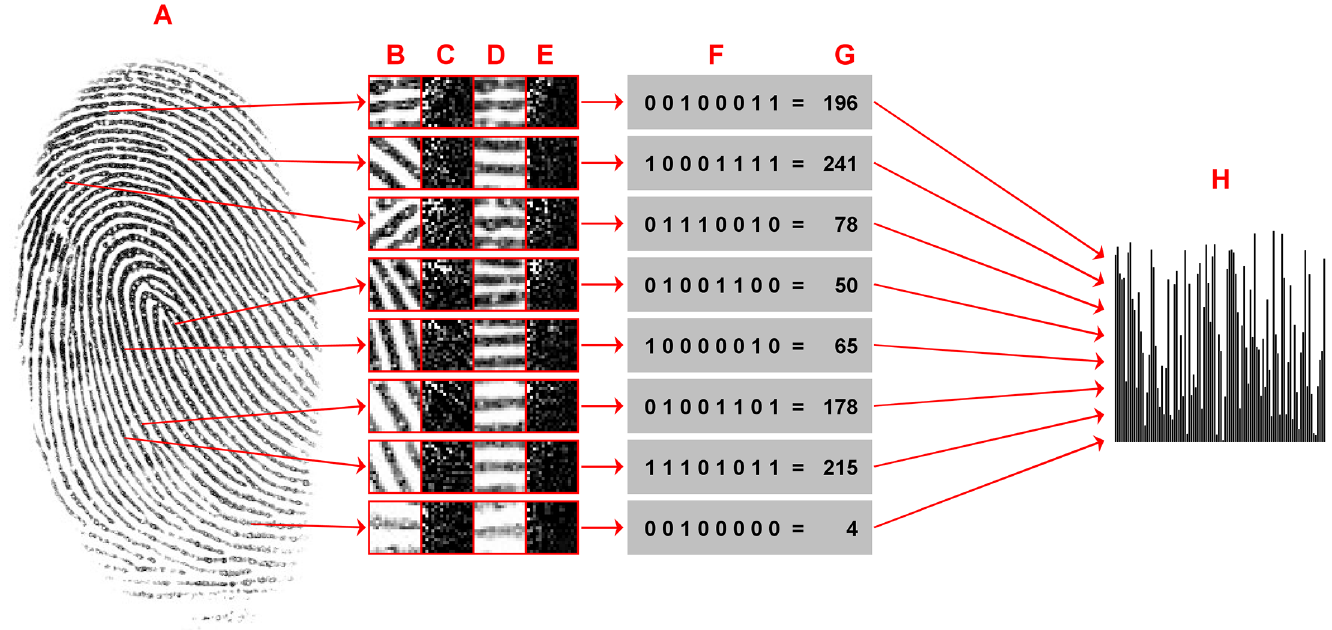
Fig 1. Overview over the proposed feature vector computation. Every foreground pixel of a fingerprint (A) is considered as the center of a small image patch. Instead of using the original patches (B) and their DCT coefficients (C), we take the local orientation into account to obtain rotation invariant patches (D) and their DCT coefficients (E). We compute the binary pattern (F) by comparing selected pairs of two DCT coefficients from (E), see Eq (2). The pattern (F) is converted intoa bin number (G), see Eq (3). A histogram (H) summarizes the relative frequency of occurrence of all local patterns for an image. (For illustrative purposes only, patch sizes are here 17×17 pixels, and coefficients with index = 1 are set to zero in (C) and (E), and (F-H) show example